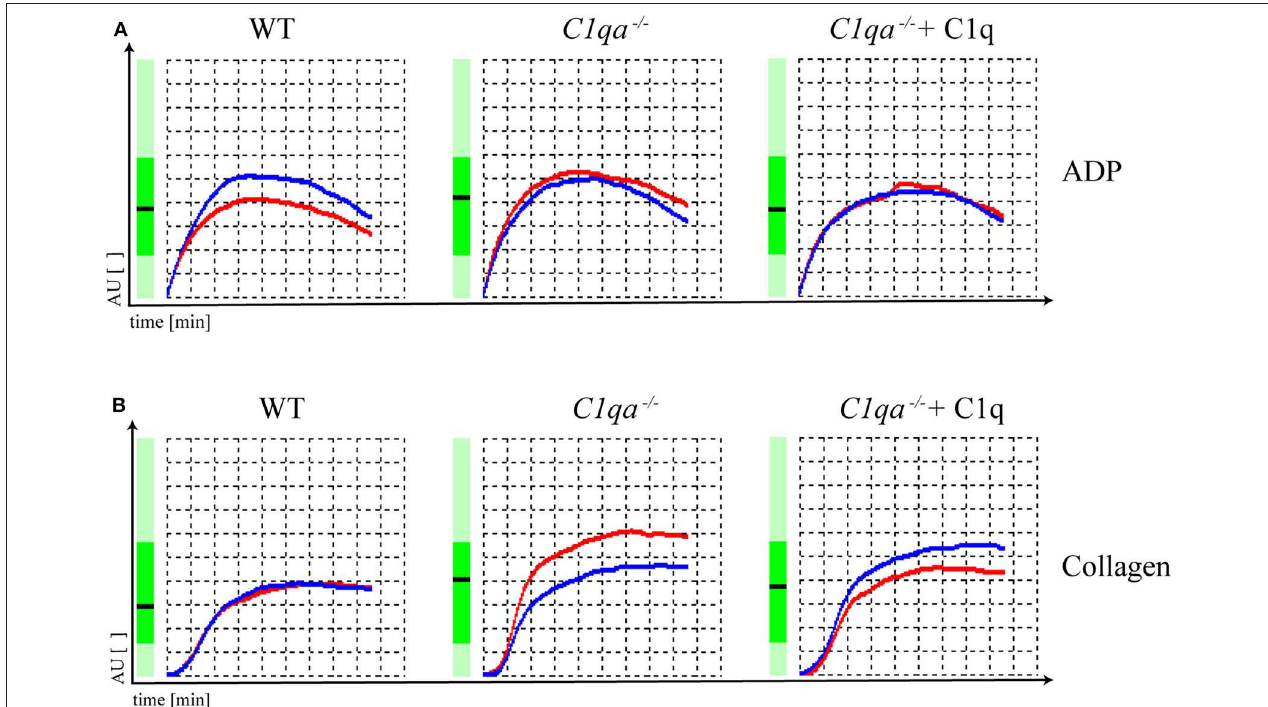
FIGURE 3 | Platelet function of C1q-deficient vs. WT mice. Hirudin-anticoagulated whole blood was obtained for functional platelet aggregation tests using (A) ADP (15 µ M) and (B) collagen (10 µ g/ml) as inducers of platelet aggregation. Platelet aggregation curve of saline injected WT mice, saline injected C1q-deficient mice and C1q injected C1q-deficient mice are shown. Electrical impedance is expressed as aggregation units (AU) and plotted over time [min]. Representative data of one out of two independent experiments are shown. For each experiment, blood from four mice per group was